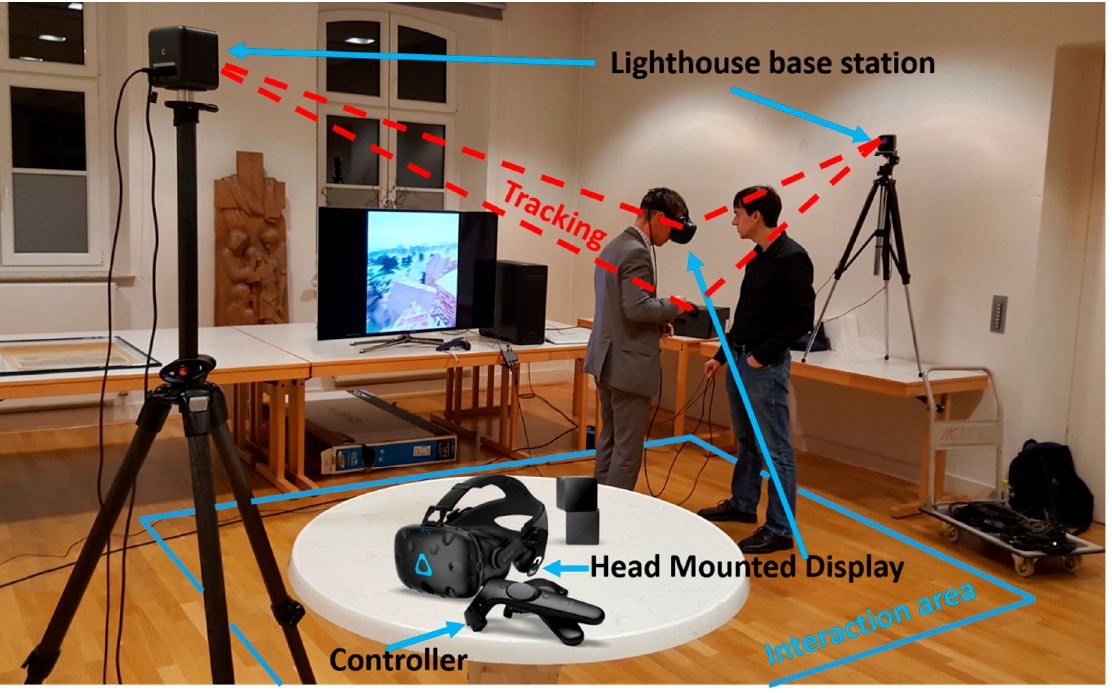
Figure 7. Components and schematic setup of the VR system HTC Vive Pro with interaction area (blue).